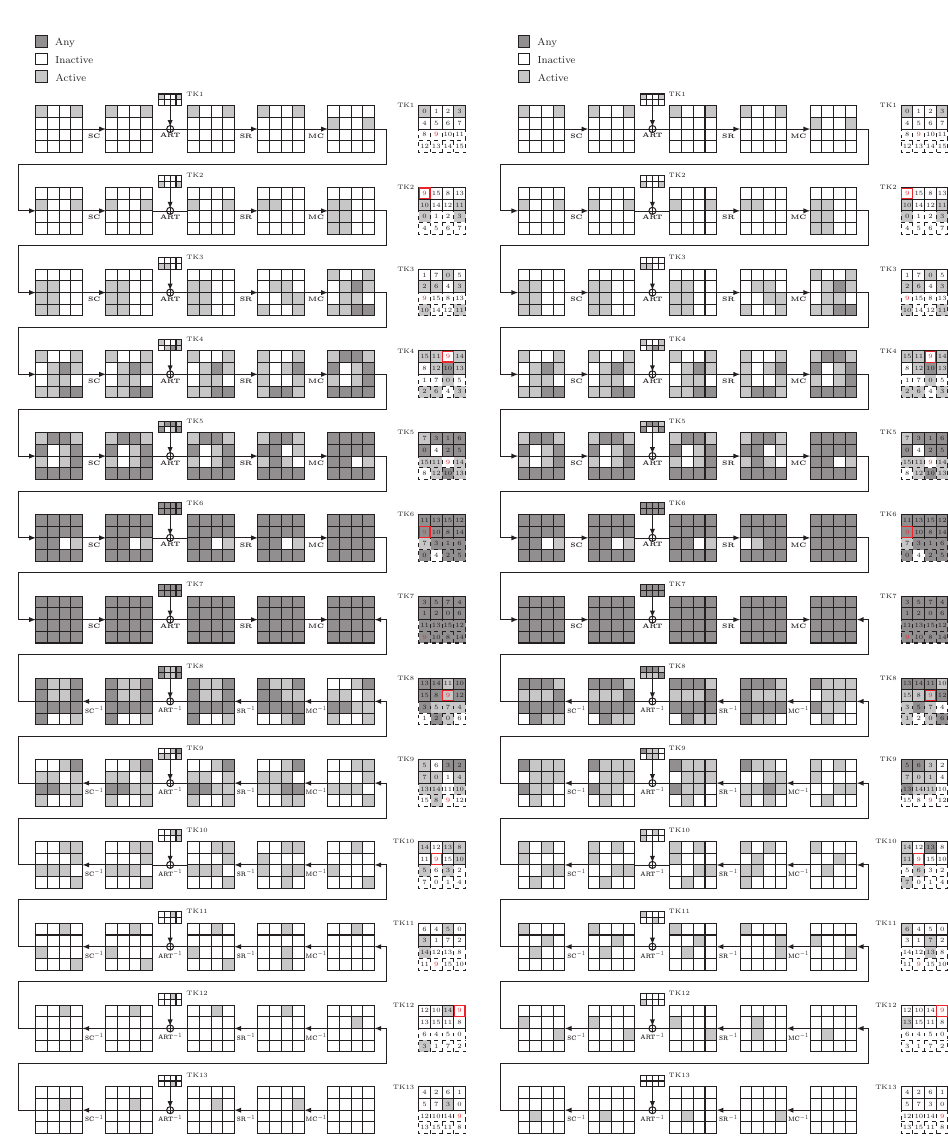
Figure 19: Two 13-round zero-correlation linear hulls for Skinny